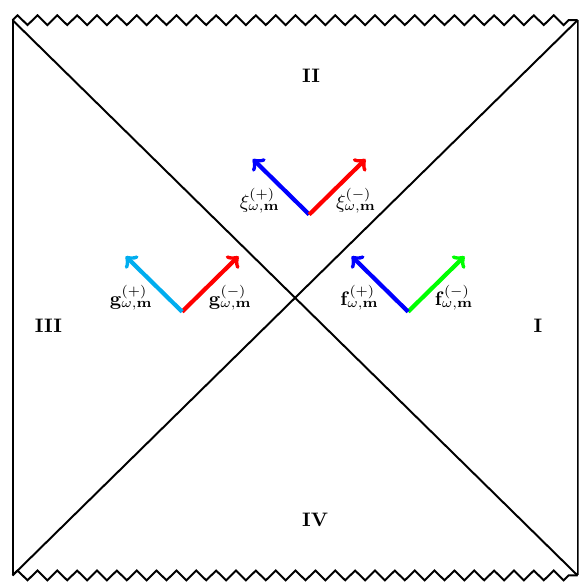
Figure 7: Bulk reconstruction in an eternal black hole. f ( ± ) are the solutions to the ω , m wave equation in region I which behave like plane waves near the horizon. A linear combination of them is the normalizable mode. The CFT representation of a field in region I will be an operator on the right boundary. In region II, we have modes coming in both from regions I and III. To obtain the CFT representation one continues back these modes to the boundary. This gives us a sum of two operators – one on the left CFT and one on the right.